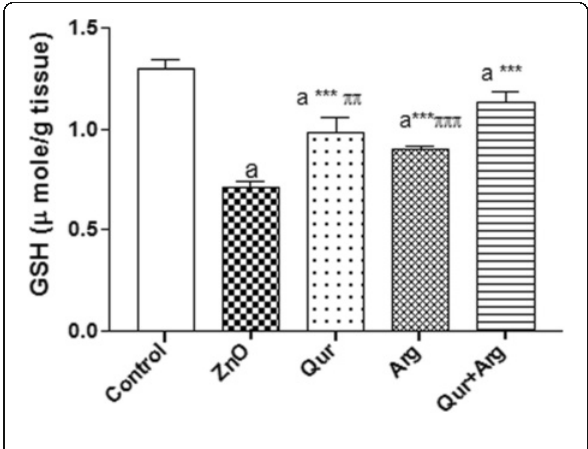
Figure 2 Effect of Qur and/or Arg treatment on serum IgG (a), VEGF (b), total nitrate/nitrite (c), and glucose (d) concentrations in intoxicated rats with a high dose of n-ZnO particles. Values